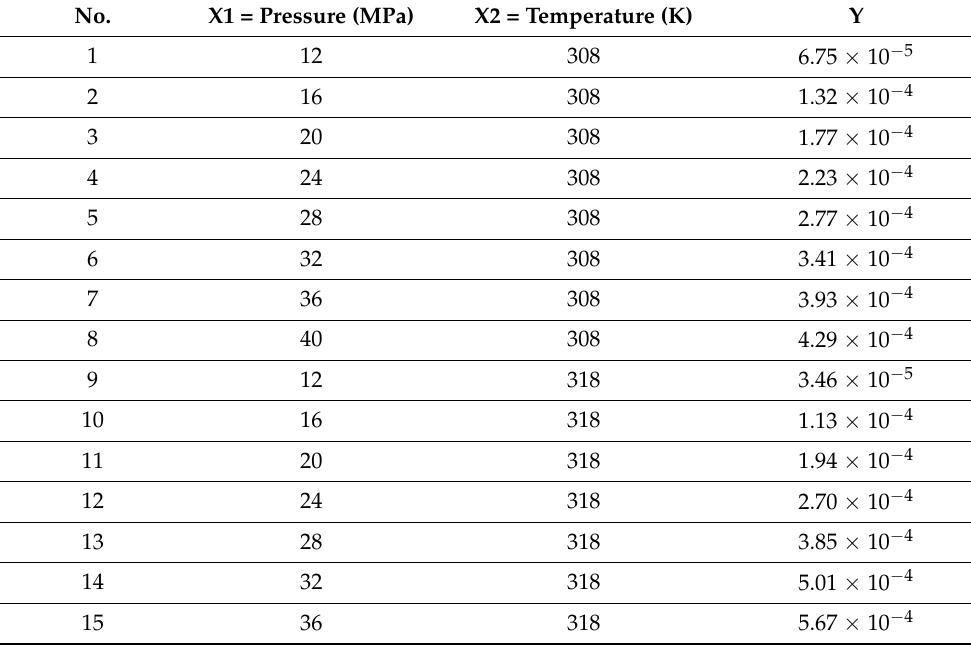
Table 2. The whole